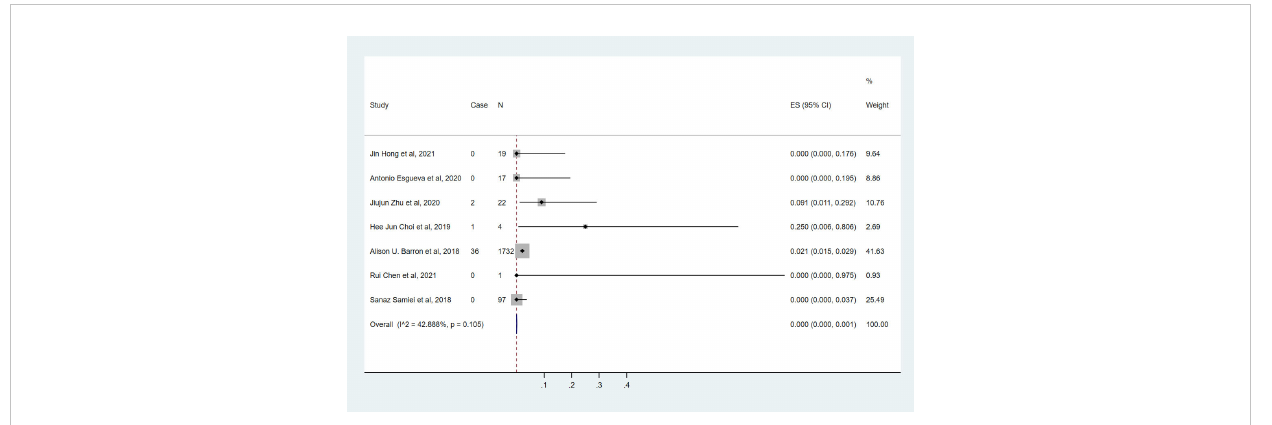
(Figure 5). The overall pooled ypN+ rate was 0.6% (95% CI, 0%- 3.2%) (22/1571 cases). With an I 2 value of 50.13% between the trials, there was signi fi cant heterogeneity (P=0.042). According to